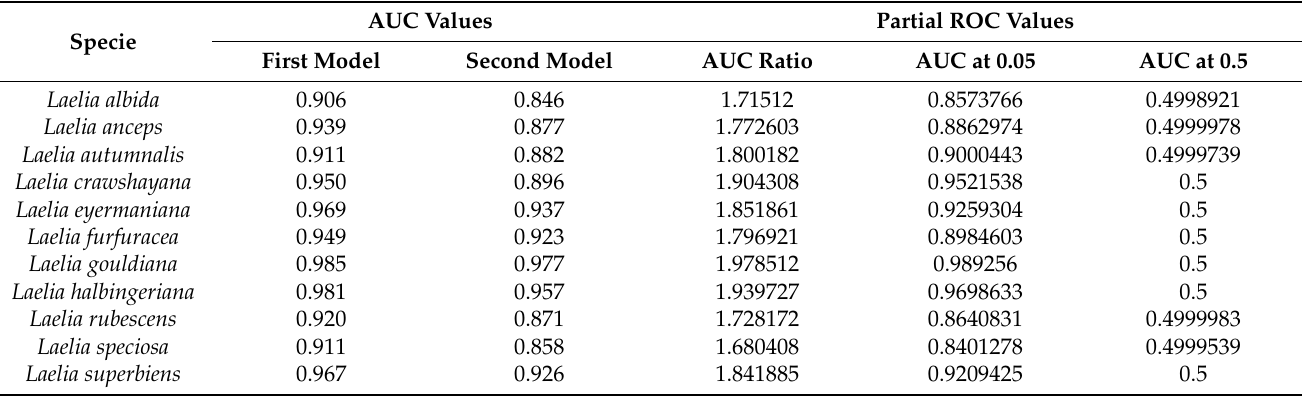
Table 2. AUC values from each potential distribution model and the partial ROC